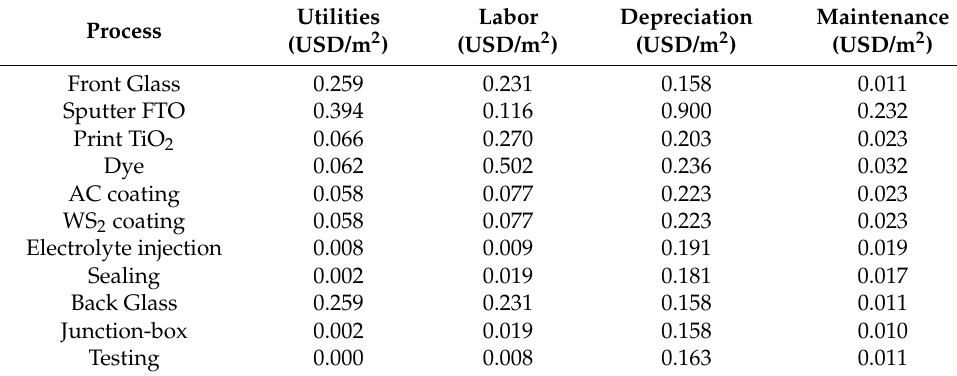
Table 3. Distribution of direct manufacturing cost in each